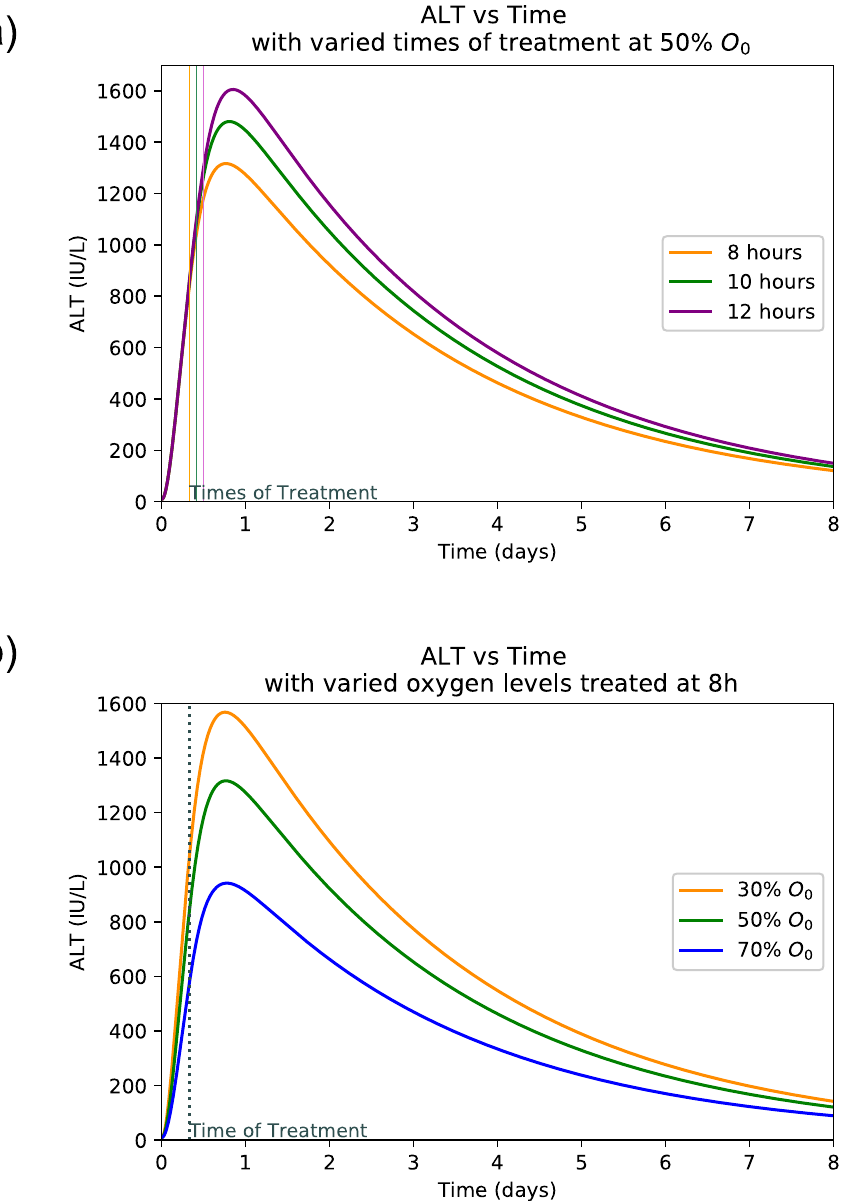
Fig 5. ALT peaks with varied times of treatment and oxygen levels. ( a ) ALT peaks with varied times of treatment at 50% oxygen level. ( b ) ALT peaks with varied initial oxygen levels treated after 8